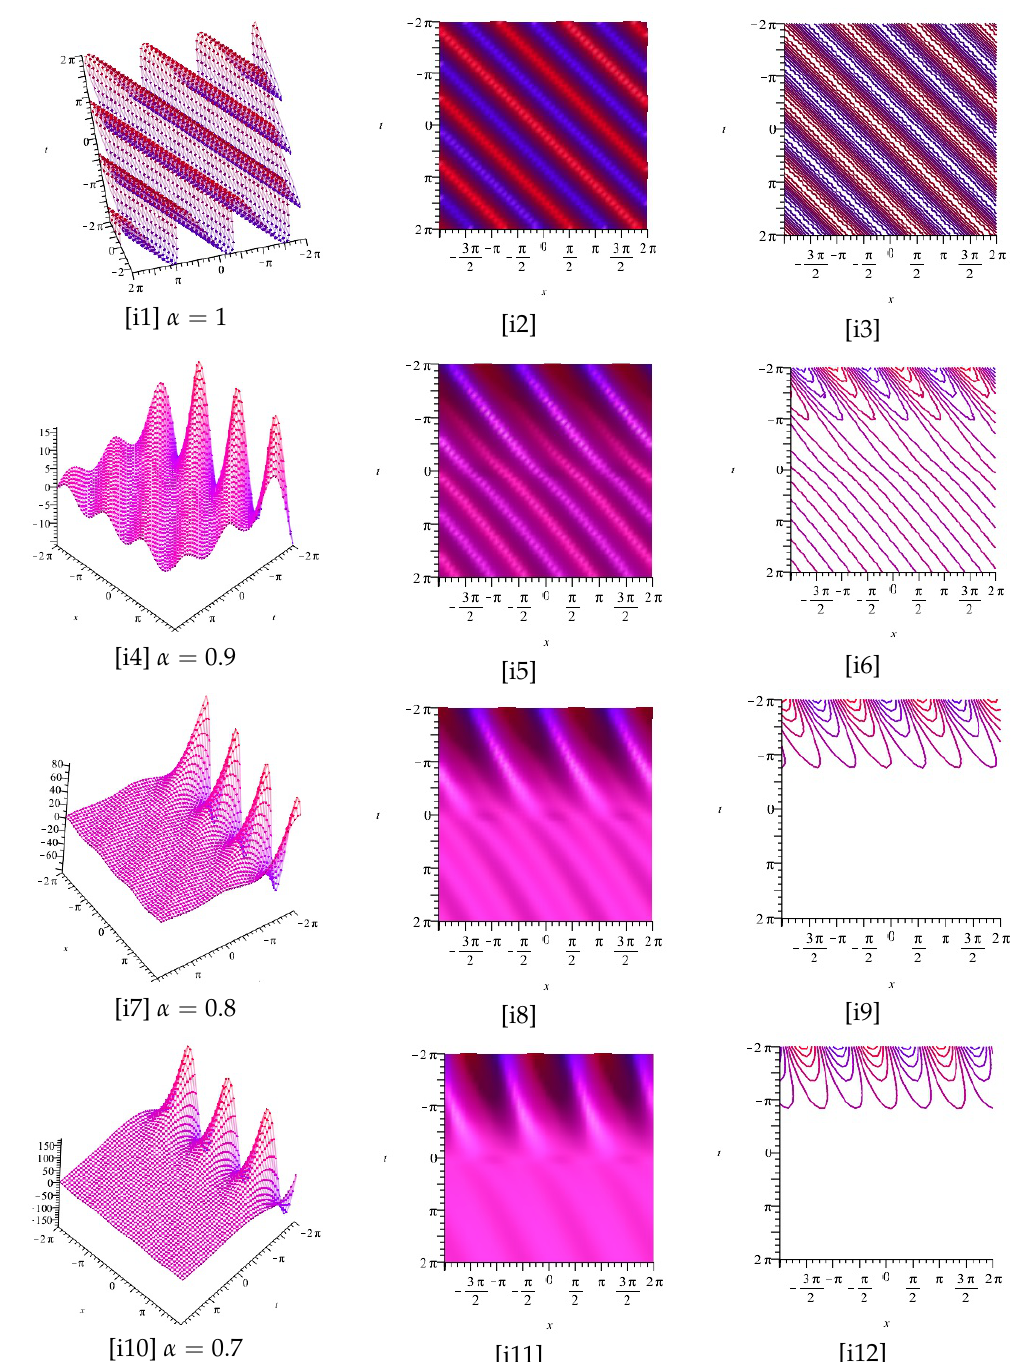
Figure 9. Now, [i1], [i4], [i7], [i10] display the plots of the imaginary part of Equation (34), for λη > 0, and [i2], [i5], [i8], [i11] as well as [i3], [i6], [i9], [i12] display the z -axis orientation and the contour plot, respectively.